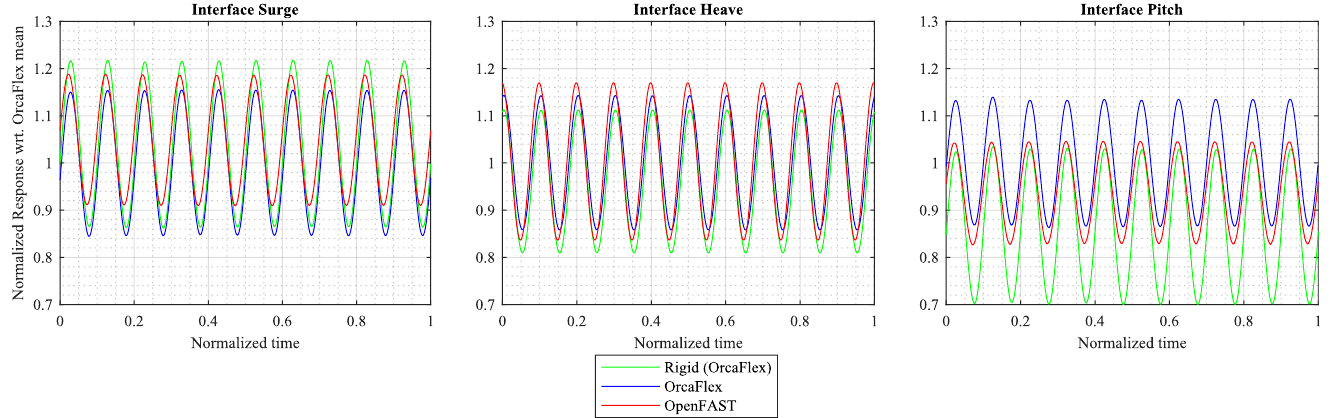
Figure 7. Comparison of motion response of the interface in a regular sea state and with a steady wind load.